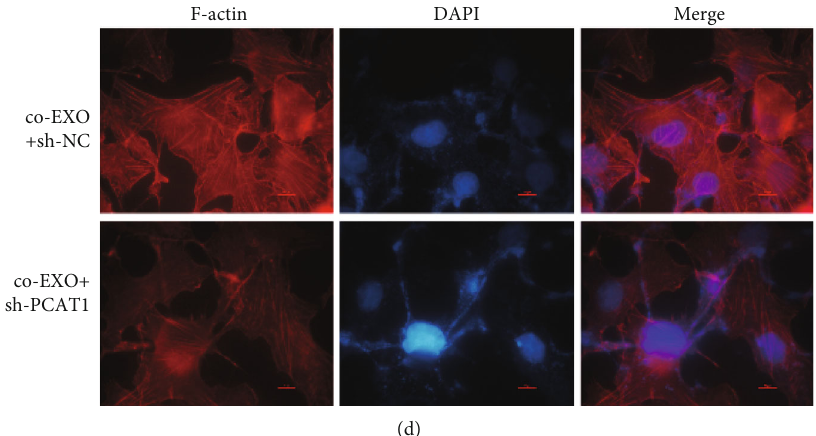
Figure 3: The e ff ect of exosomal PCAT1 on the EMT process and fi brous actin. (a) Western blot was used to detect the expression of EMT- related proteins in exosomes co-cultured with T84. (b) The changes of F-actin after co-culture of exosomes with HUVECs were detected by immuno fl uorescence. ∗∗ P < 0 : 01 vs Control. (c) Western blot was used to detect the expression of EMT-related proteins in exosomes co- cultured with T84 after PCAT1 knockdown. (d) The changes of F-actin in exosomes and HUVECs co-cultured after PCAT1 knockdown were detected by immuno fl uorescence. ∗∗ P < 0 : 01 vs